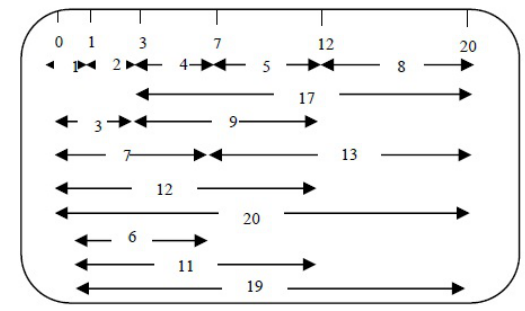
Figure 2: A 6–marks non–OGR with its associated